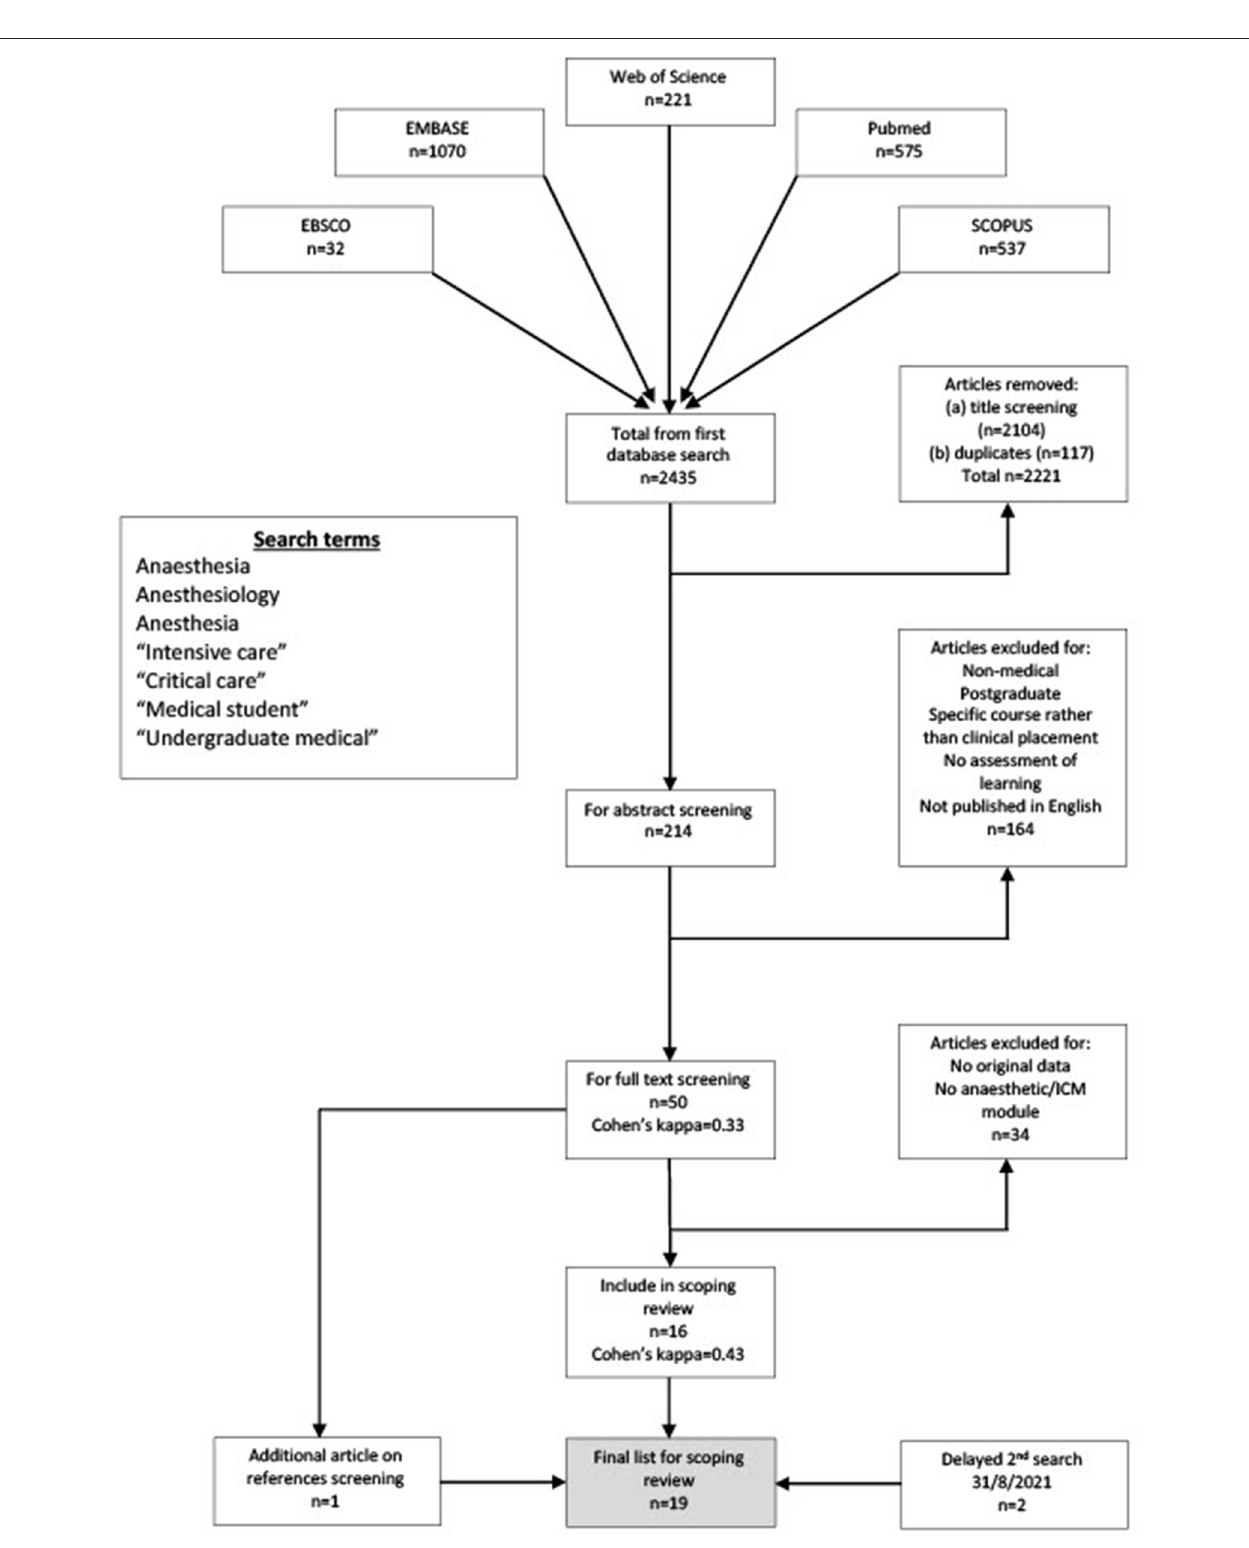
FIGURE 1 | PRISMA flow diagram for the scoping review process. (ICM, intensive care medicine).